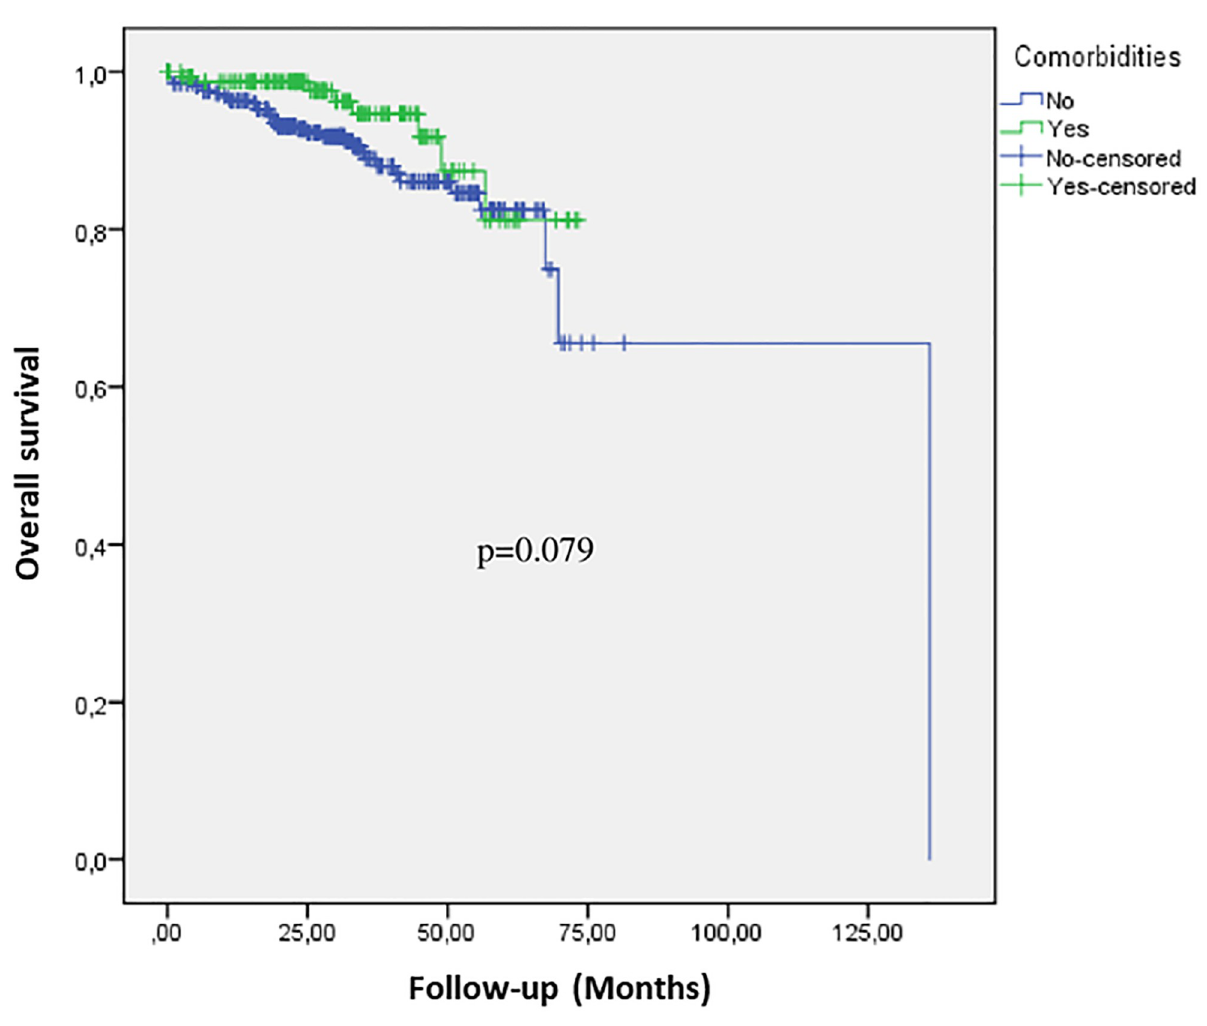
Fig 2. Kaplan Meier estimates overall survival according to comorbidity status. Blue line represents non-comorbid patients and green line comorbid cases.